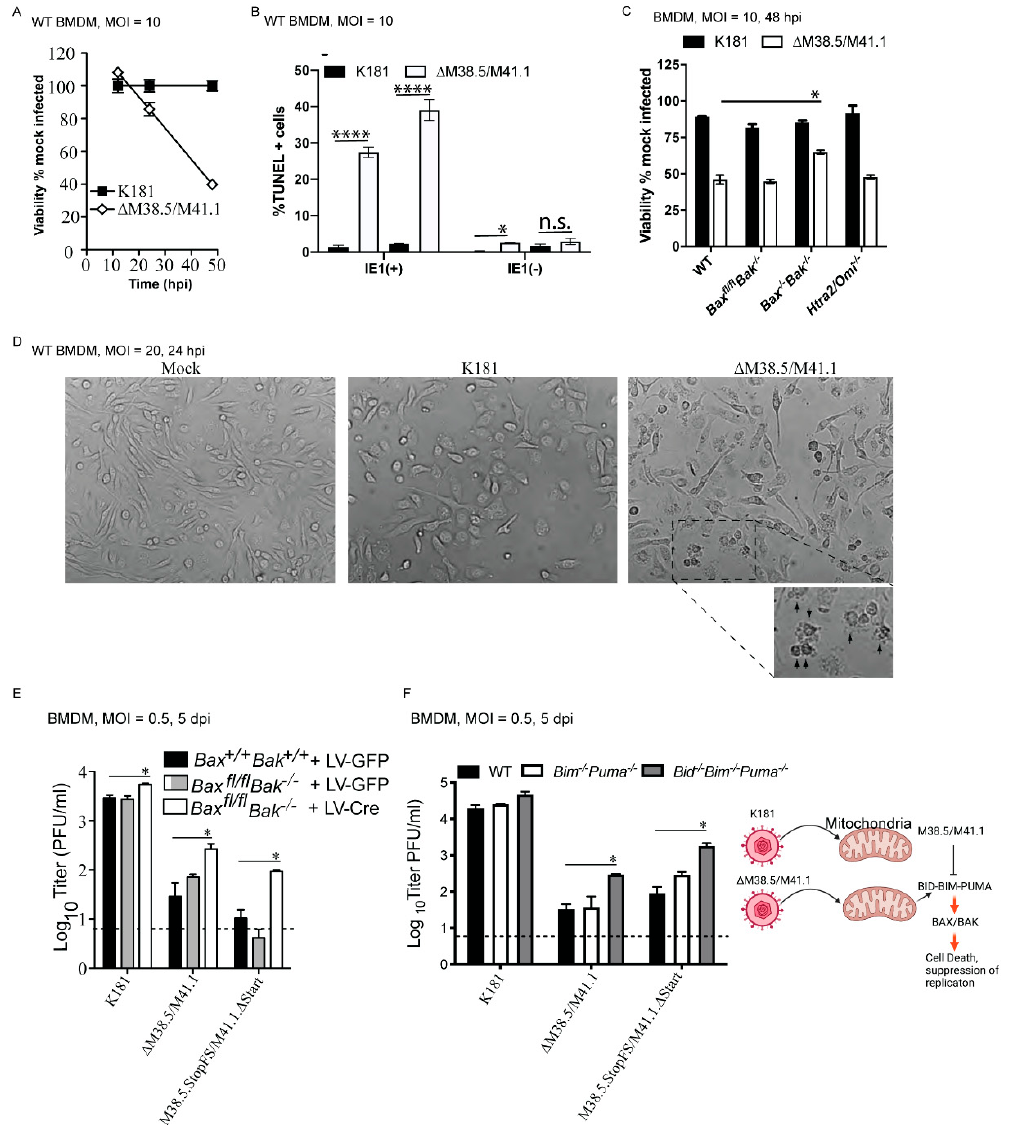
Figure 2. M38.5 and M41.1 suppress BAX- and BAK-dependent BMDM viability. ( A ) Viability of WT BMDM infected with K181 or ∆ M38.5/M41.1 (MOI = 10) measured by the loss of ATP at indicated times. Each bar or symbol represents pooled data obtained from a minimum of three replicates. ( B ) Quantification of DNA fragmentation by TUNEL assay in BMDM (MOI = 10) that either show (+) or lack ( − ) viral antigen IE1 at 24 and 48 hpi. Each bar represents pooled data from three replicates and shows the average percentage of TUNEL positive cells. ( C ) Viability of WT, Bak − / − Bax fl/fl , Bax − / − Bak − / − , as well as Htra2/Omi − / − BMDM under the conditions described in 2A. Comparison between ∆ M38.5/M41.1 infection in WT and Bax − / − Bak − / − cells was performed using Wilcoxon matched-pairs signed rank test. ( D ) Cell morphology during infection was visualized by phase-contrast microscopy of infected BMDM (MOI = 20). Representative images were obtained at 24 hpi. The highlighted area in the right-most panel exhibits visible apoptotic cell morphology (indicated by black arrowheads). ( E ) Replication of K181, ∆ M38.5/M41.1, or M38.5.StopFS/M41.1 ∆ Start virus in Bax +/+ Bak +/+ and Bax fl/fl Bak − / − BMDM previously transduced with a lentivirus expressing GFP (LV-GFP) or Cre recombinase (LV-Cre) at 5 dpi (MOI = 0.5) with MCMV. ( F ) Replication of K181, ∆ M38.5/M41.1, or M38.5.StopFS/M41.1 ∆ Start virus in Bim − / − Puma − / − and Bid − / − Bim − / − Puma − / − BMDM at 5 dpi (MOI = 0.05). For each experiment, data shown are pooled results from at least three experiments. Horizontal lines indicate groups of data being compared by Wilcoxon matched-pairs signed rank test. Comparisons of the three bars shown in Panels E and F were performed using one-way ANOVA. Error bars indicate standard error and mean for each dataset. * is p <= 0.05; **** is p < 0.0001; n.s. is non-significant. Cartoon diagram ( F right panel) generated using BioRender illustrates the function of M38.5/M41.1 during MCMV infection of